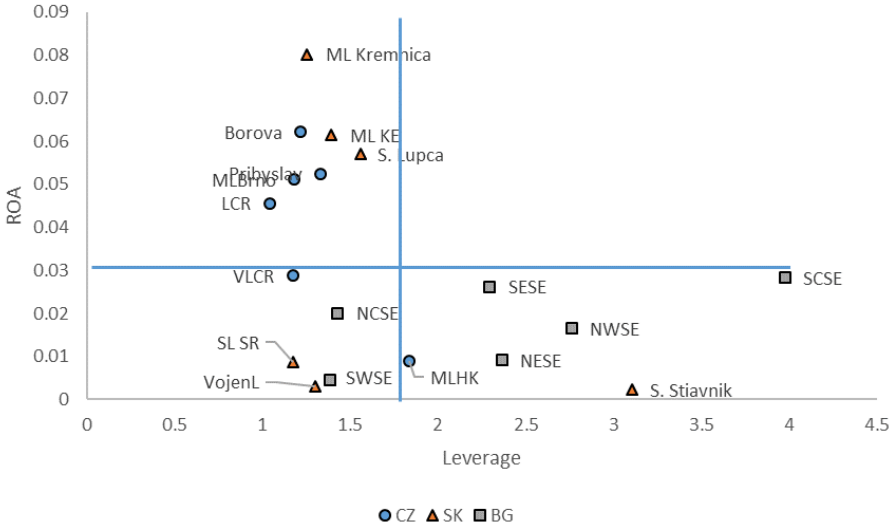
Figure 1. Grouping the enterprises according to the average leverage and ROA (Origin of authors).